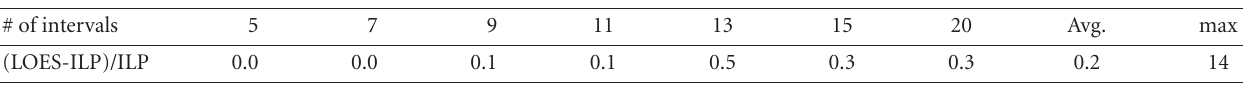
Table 3: Performance comparison of LOES algorithm with integer linear programming (optimal) for randomly generated graphs (unit: